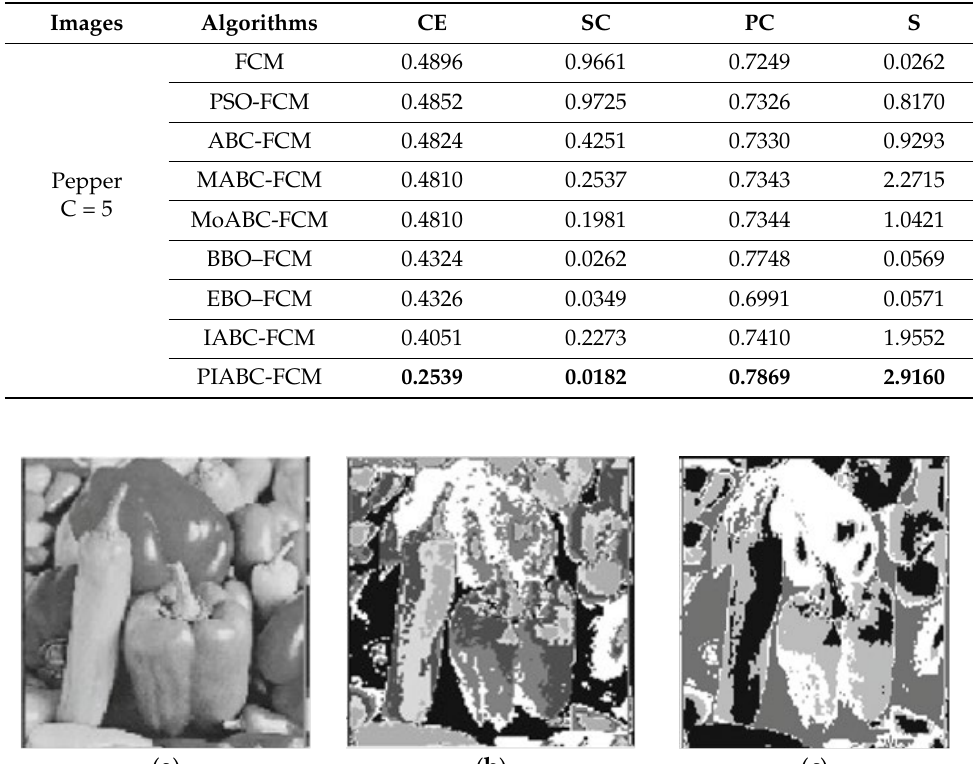
Table 5. Outcomes of PIABC-FCM and other clustering algorithms on the pepper image.